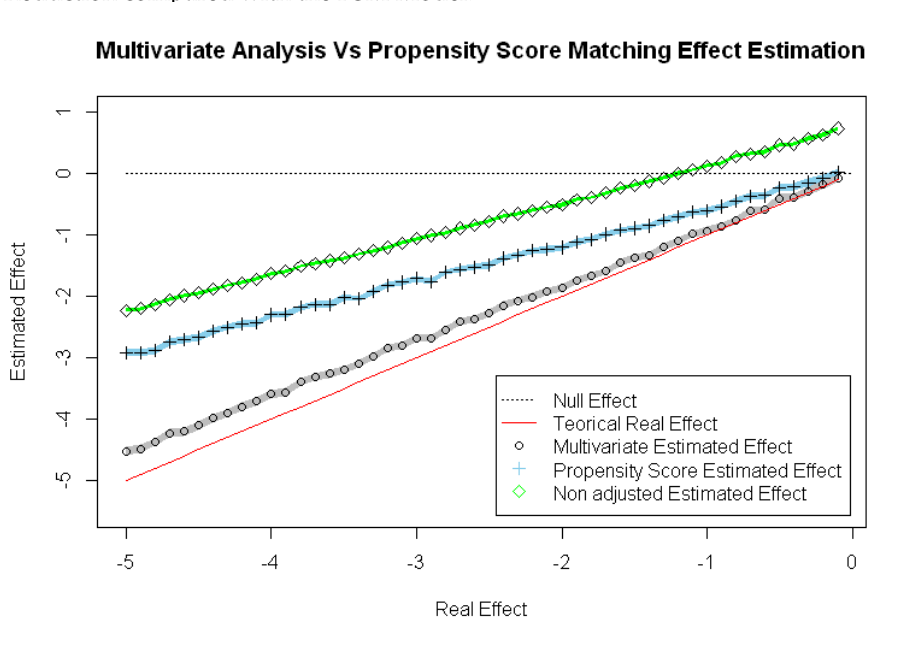
Figure 2. Comparison of Real Treatment Effect and Real Treatment Effect Estimation from the Unadjusted Model, Multivariate Regression Model and Propensity Score Matching Model.